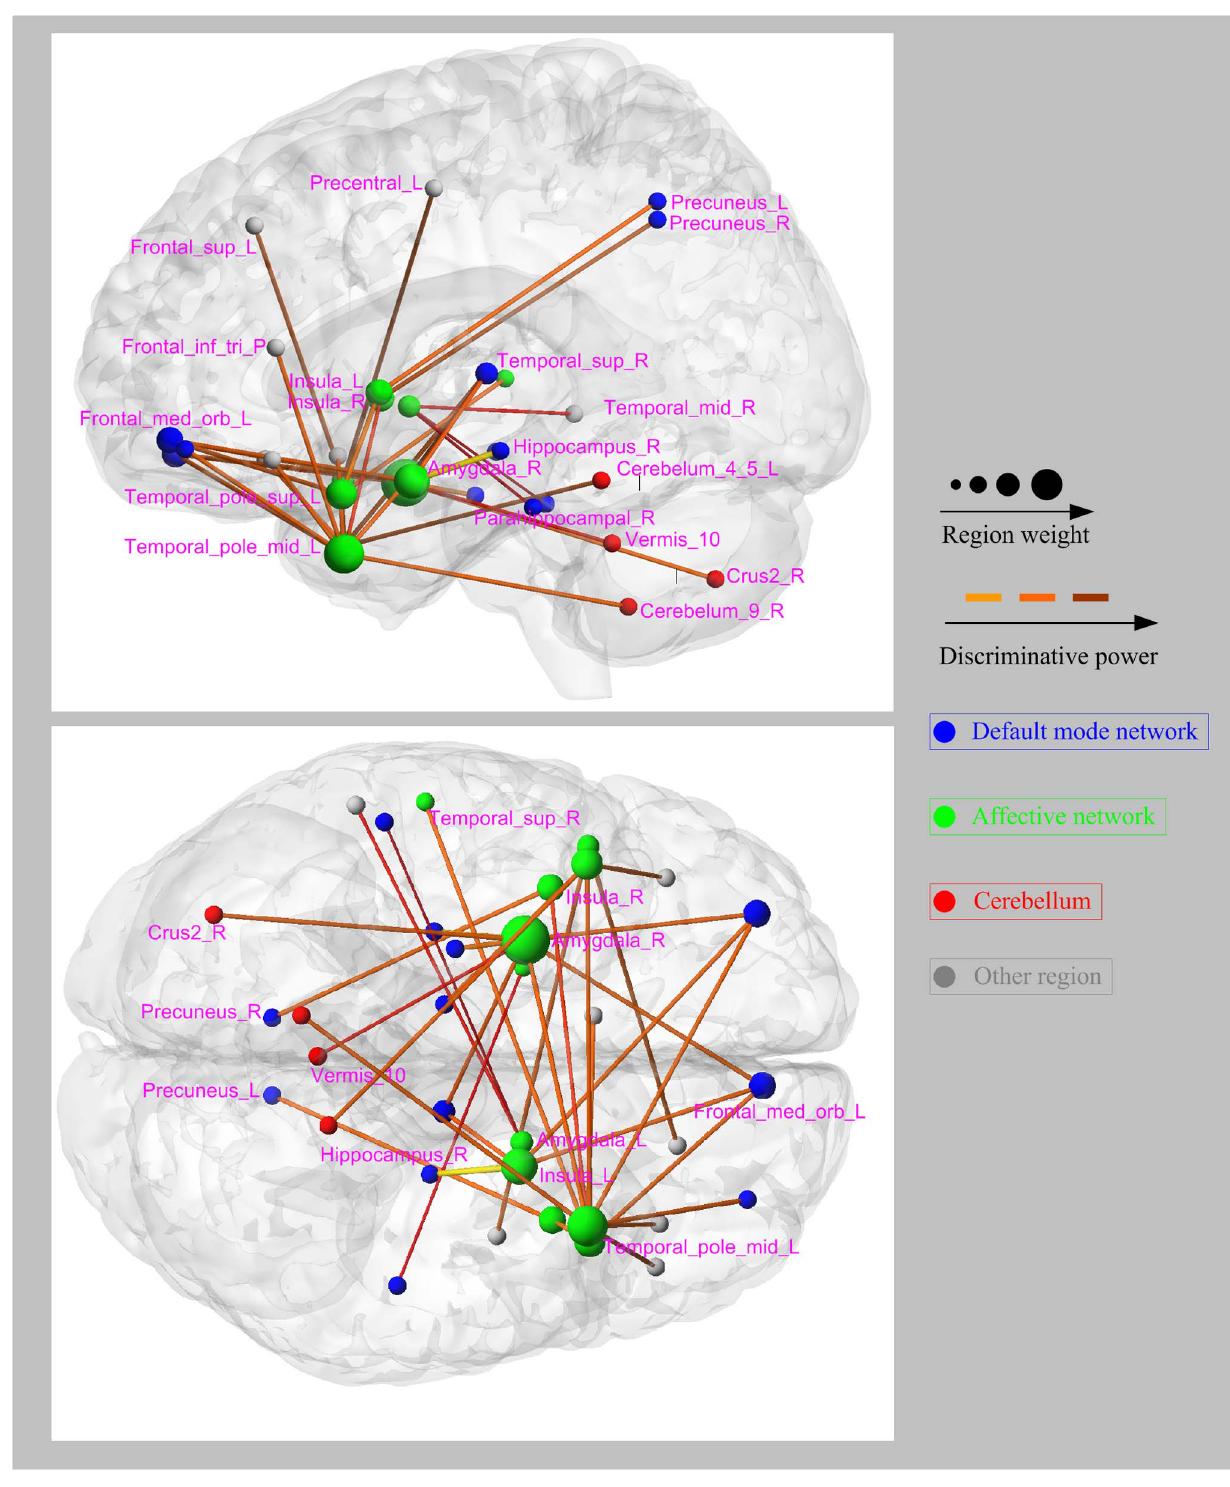
Figure 5. Left and bottom views of the divergent functional connectivity patterns with high discriminative power. Regions are color- coded by category. The line colors representing the discriminative power of the relative connections are scaled with their mean discriminative power in the leave-one-out cross-validation.